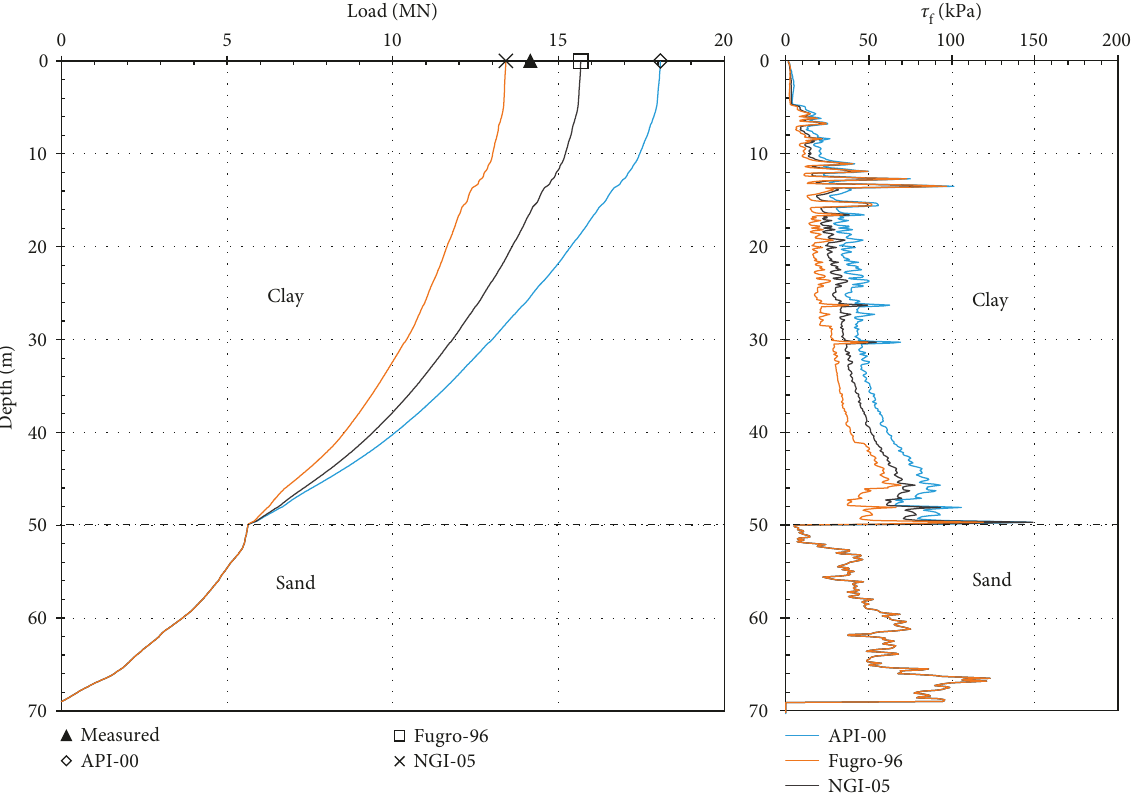
Figure 13: Load transfer behavior and shaft resistance distribution with depth during ultimate tension bearing calculated by different design